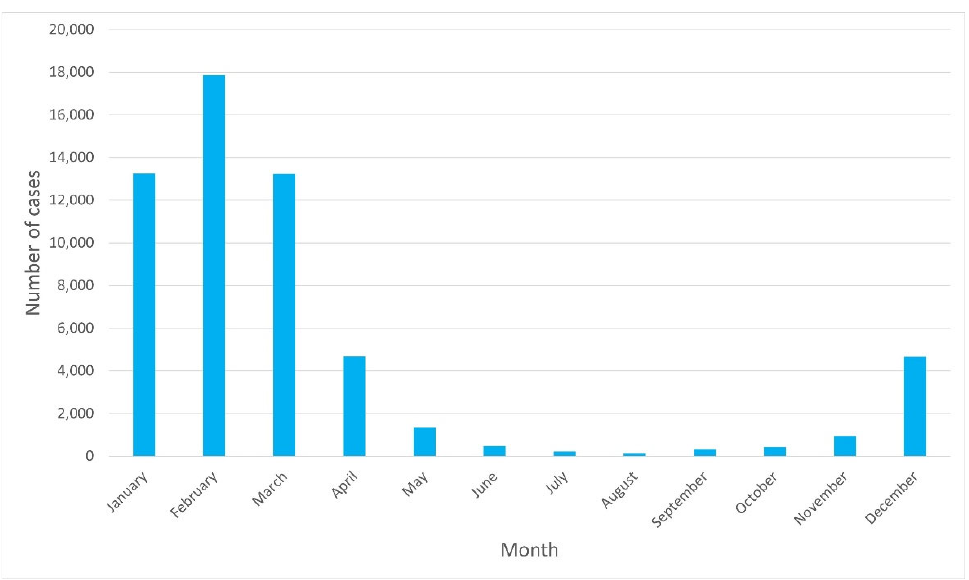
Figure 1. Number of hospitalizations among RSV children below 5 years in Poland, 2010 – 2020. The highest hospitalization rates were observed from January to March, and the lowest ones were in August. Thus, a seasonal pattern can be assumed, as presented in Figure 2.